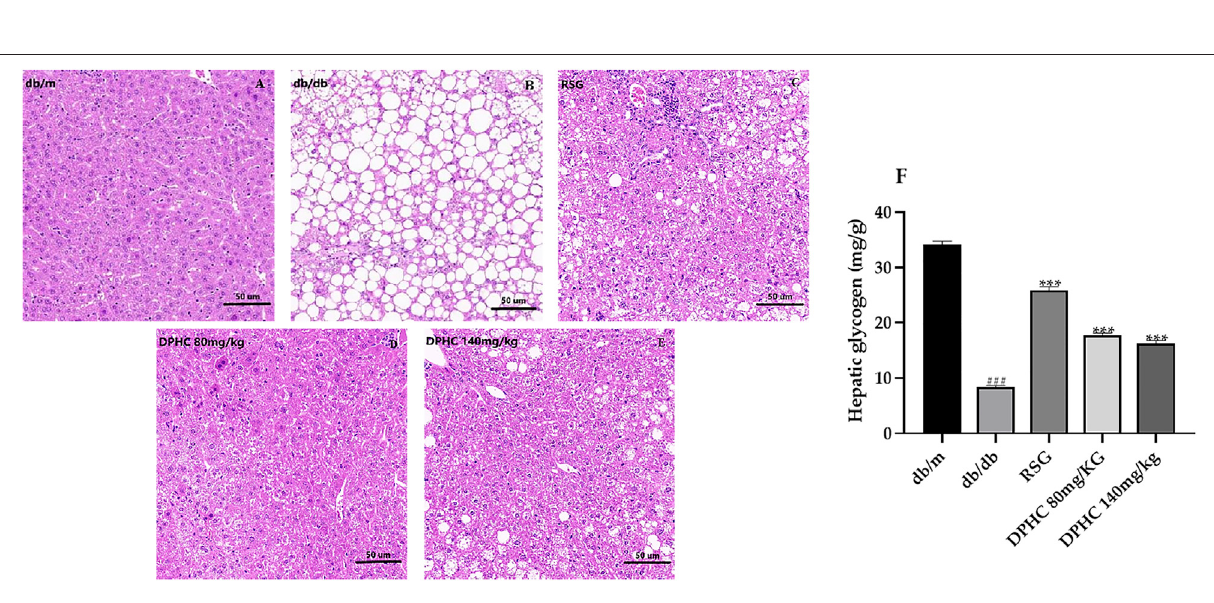
FIGURE 5 | Effects of DPHC on liver tissue histopathological changes and hepatic glycogen contents in db/db mice. (A – E) Histopathological changes in the livers ofmice.Magni fi cation is200 × . (F) Liverglycogenlevelsinmice.Allvaluesareexpressed asmeans ± SD,n (cid:1) 9.*** p < 0.001compared withthedb/db group,and ### p < 0.001 compared with the db/m